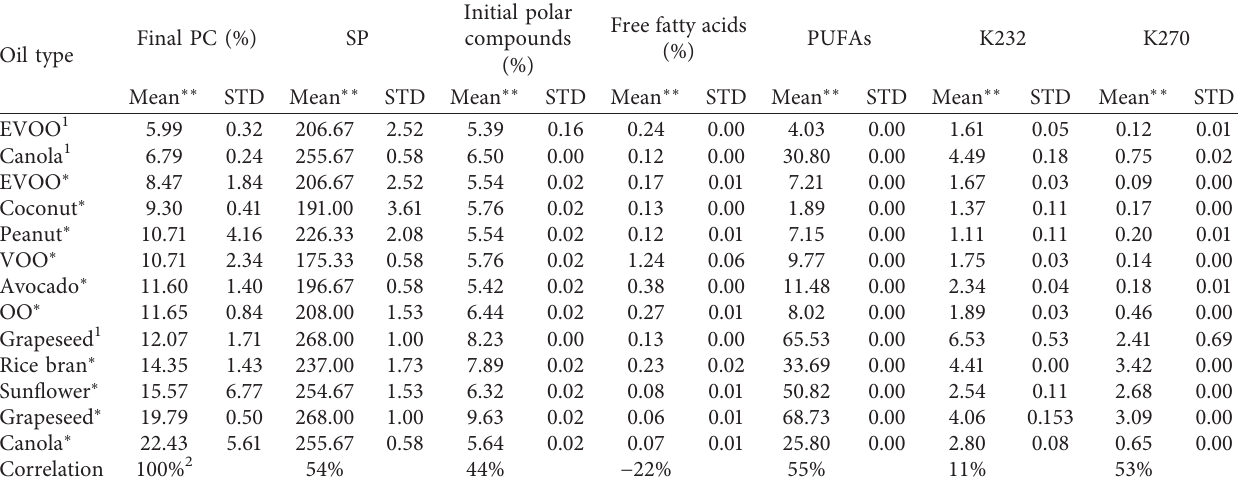
Table 6: Correlation